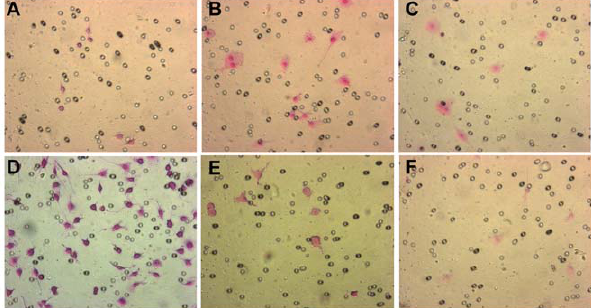
Figure 5. LOS induced MMP-9 is the key molecule responsible for macrophage invasion. RAW 264.7 cells were cultured in martigel invasion chamber (8.0 m M pore size) and treated with LOS and SP600125 as described in materials and methods. After 18 h of incubation, upper surface cells were removed and cells migrated to lower surface were stained with H&E and observed under microscope. A, untreated, B, LOS (100 ng/ml), C, SP600125 (10 m M), D, LOS + SP600125, E, LOS + MMP-9 inhibitor, F, LOS + SP600125 + MMP-9 inhibitor. Magnification 6 200. Typical results of three independent experiments are